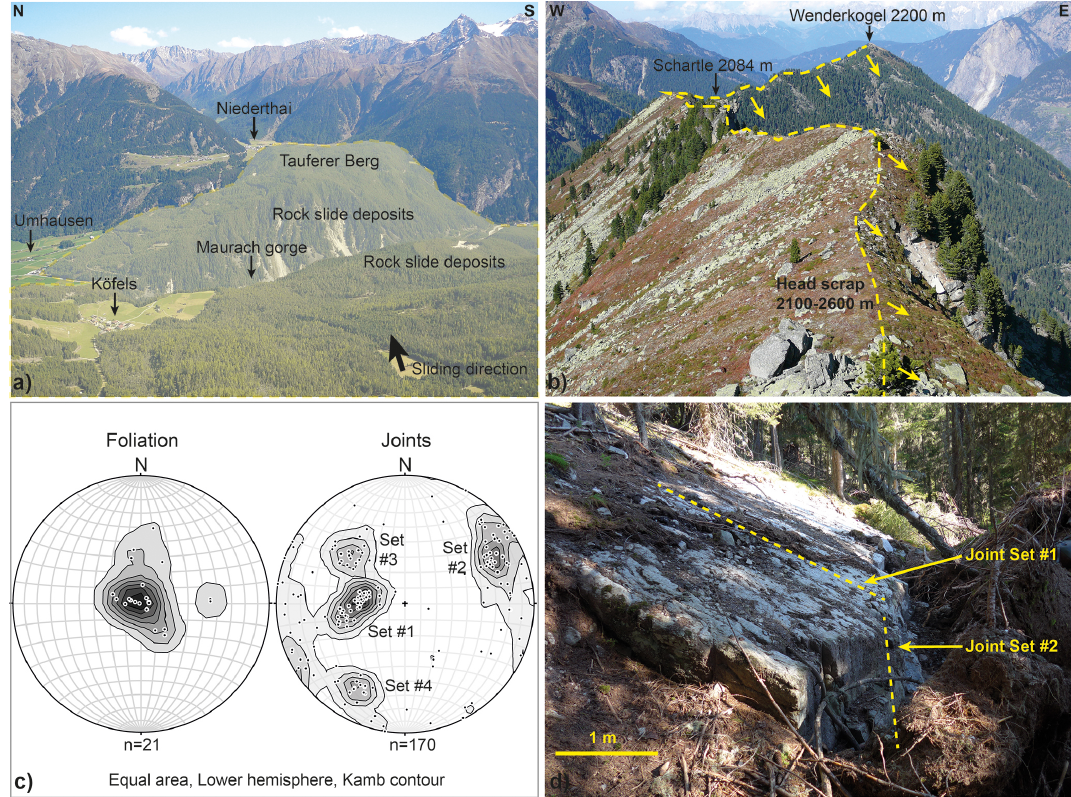
Figure 1. (a) Panoramic view of the Köfels rockslide deposits from head scarp towards the east with the Maurach Gorge cutting through the deposits (centre) and the backwater sediments in Niederthai (right), (b) view of the head scarp from south to north, (c) measured foliation and joint planes (poles to planes) in the surroundings of the central part of the head scarp, and (d) outcropping rupture surface formed along a moderately dipping plane of joint set #1 and linked with joint set #2 (stepped failure plane). Stereonet pole and contour plots were created using the Stereonet software (Allmendinger, 2018; Cardozo and Allmendinger,